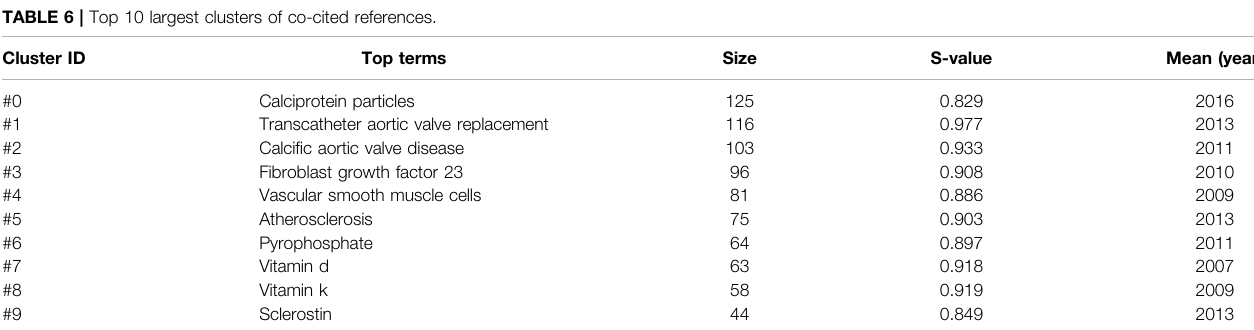
TABLE 6 | Top 10 largest clusters of co-cited references.